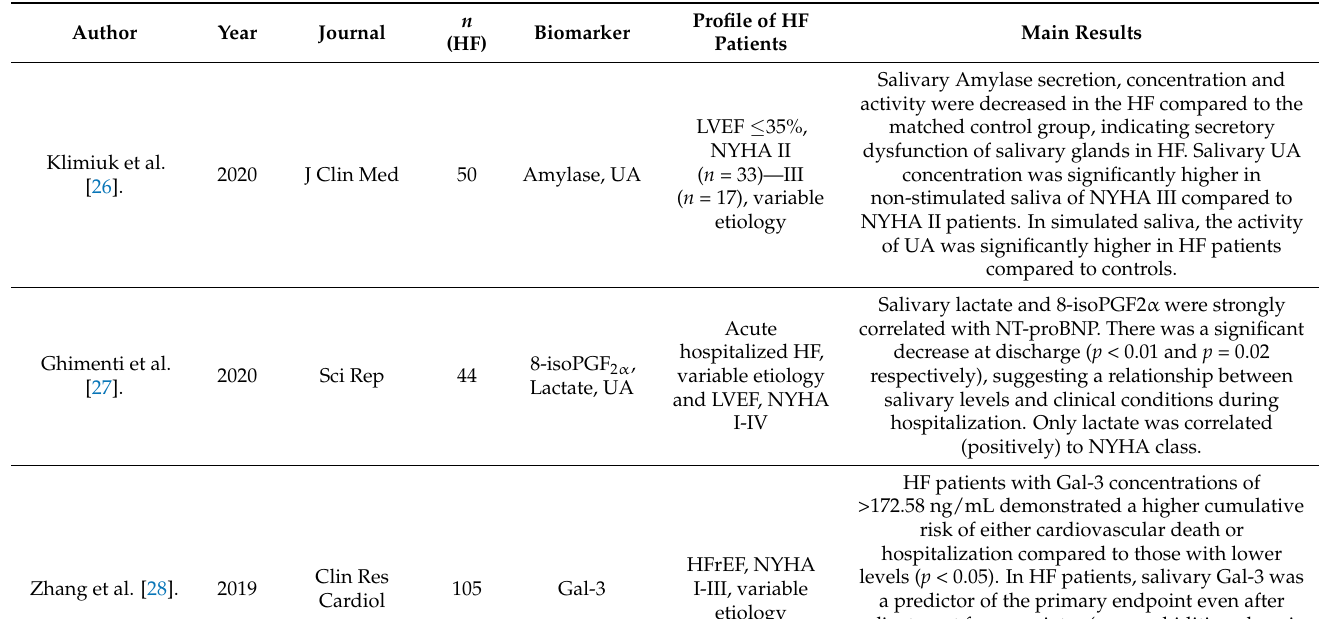
Table 1. Studies included in the review, arranged by year of publication